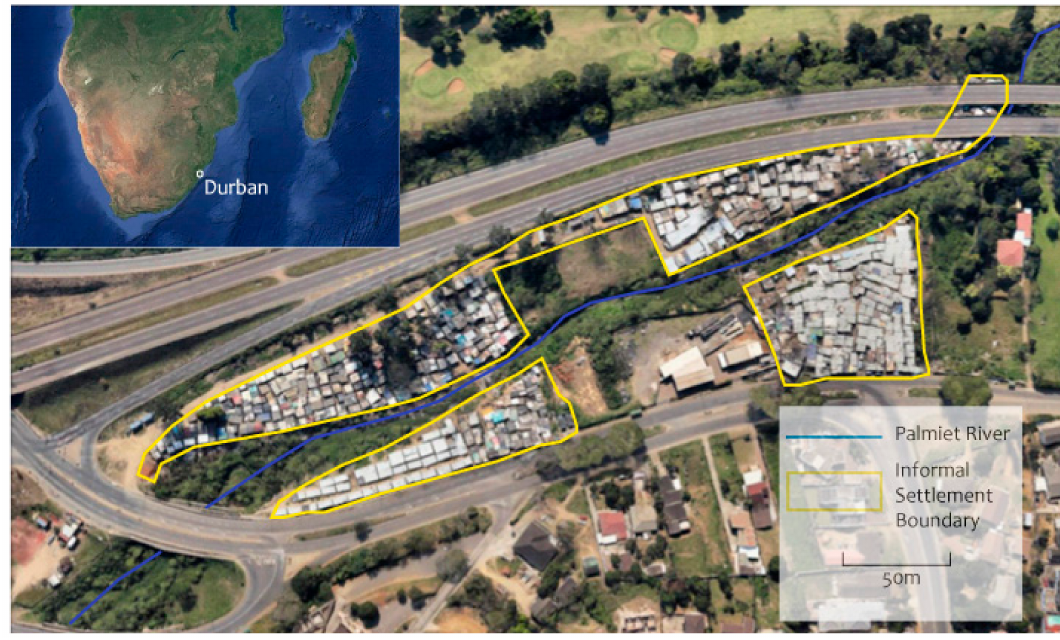
Figure 1. Four sections of Quarry Road West informal settlement intersected by the Palmiet River flowing from west to east. The location of Durban in the southern African context is illustrated in the top left-hand box. Google Earth, 2016, 29 ◦ 48 (cid:48) 53.41 (cid:48)(cid:48) S, 30 ◦ 54 (cid:48) 57.79 (cid:48)(cid:48) E, AfriGIS (Pty) Ltd., DigitalGlobe, https://earth.google.com